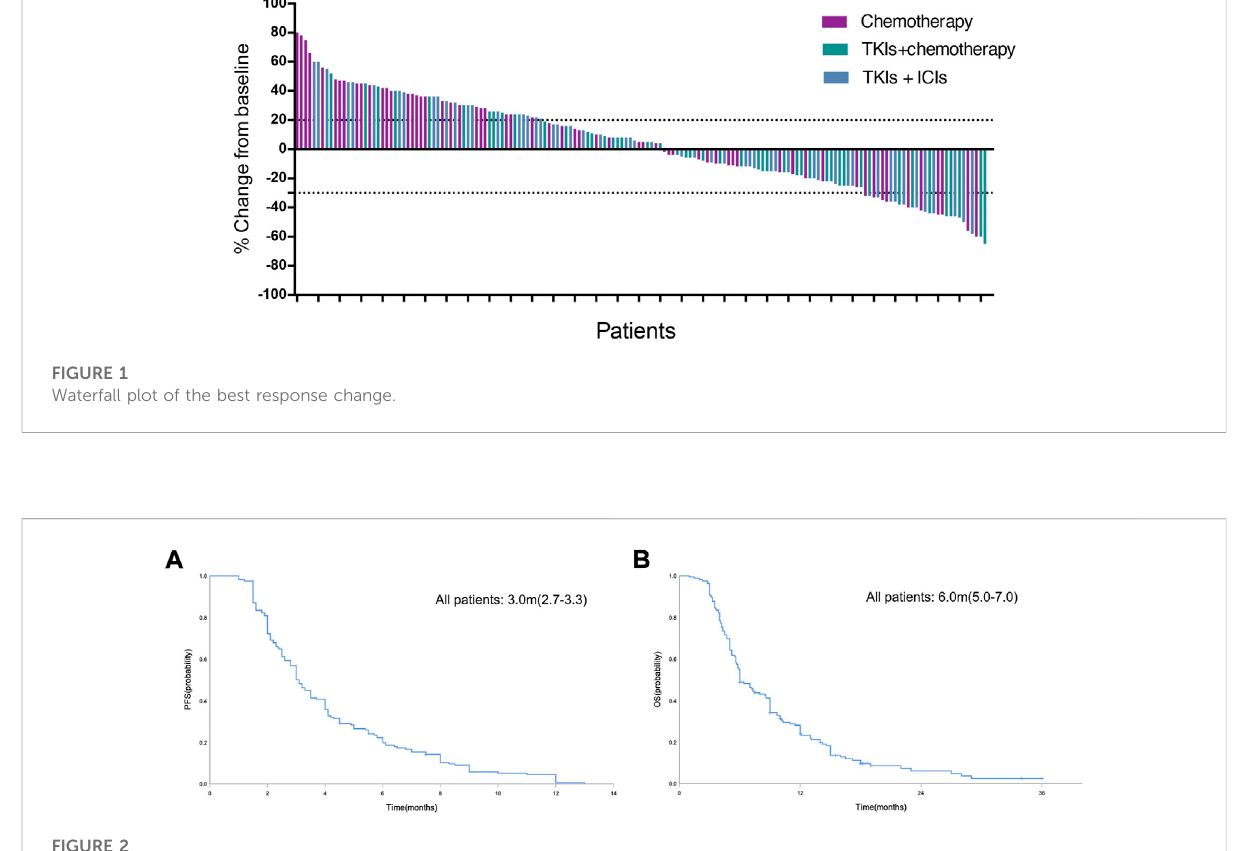
FIGURE 2 Kaplan-Meier curve of PFS (A) and OS (B) in the general